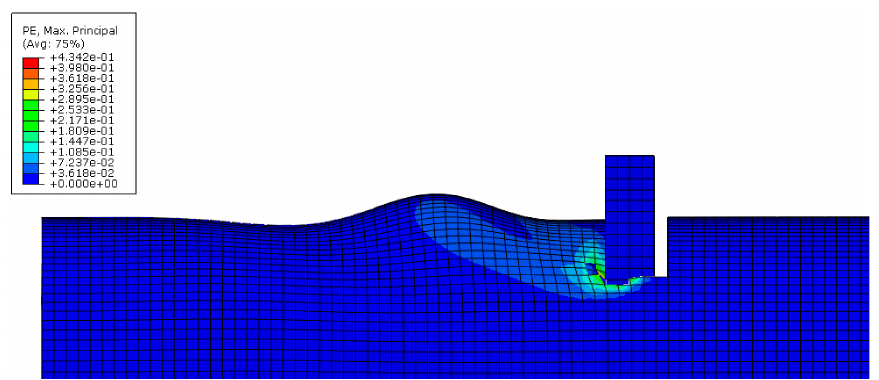
Figure 11. Principal plastic deformation of the tube under localised transverse compression (lateral view, Case 10).